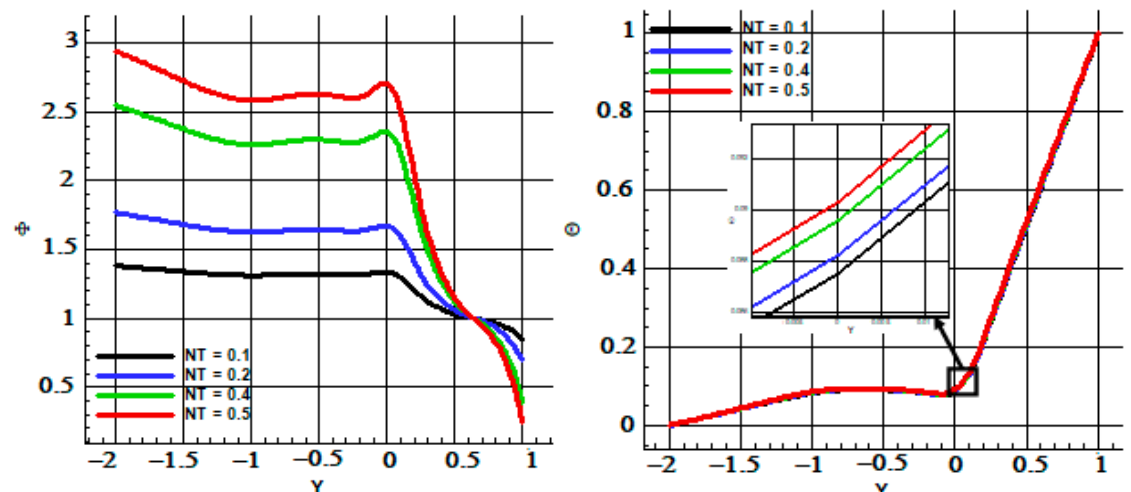
Figure 11. Concentration and temperature for different N T number and Pr = 6.2, Re = 100, Le = 1, N B = 0.1. N B = 0.1.